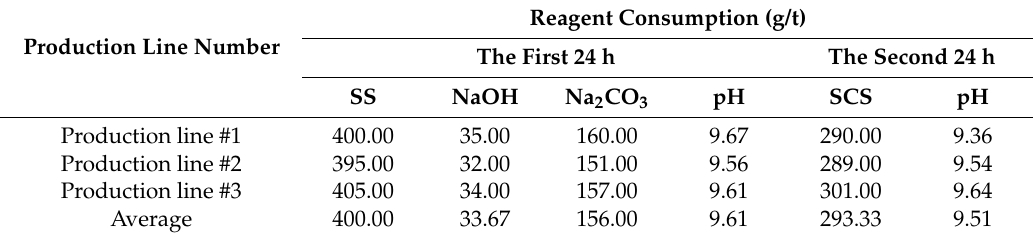
Table 4. Various conditions for the industrial tests in the Chadormalu flotation circuits.